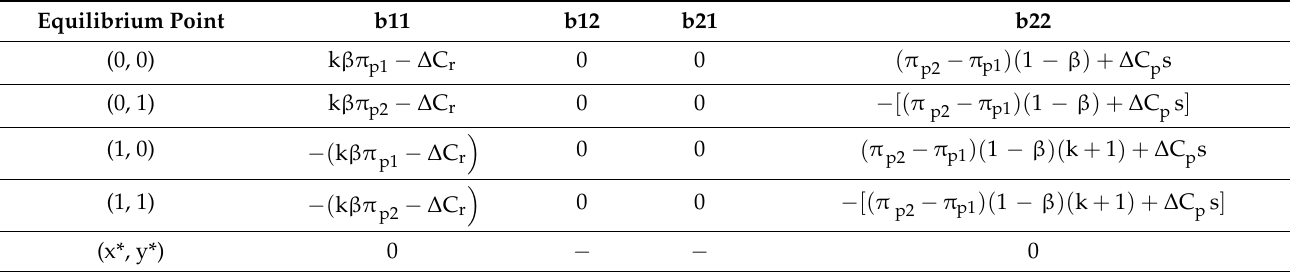
Table 14. The value of each partial equilibrium point.